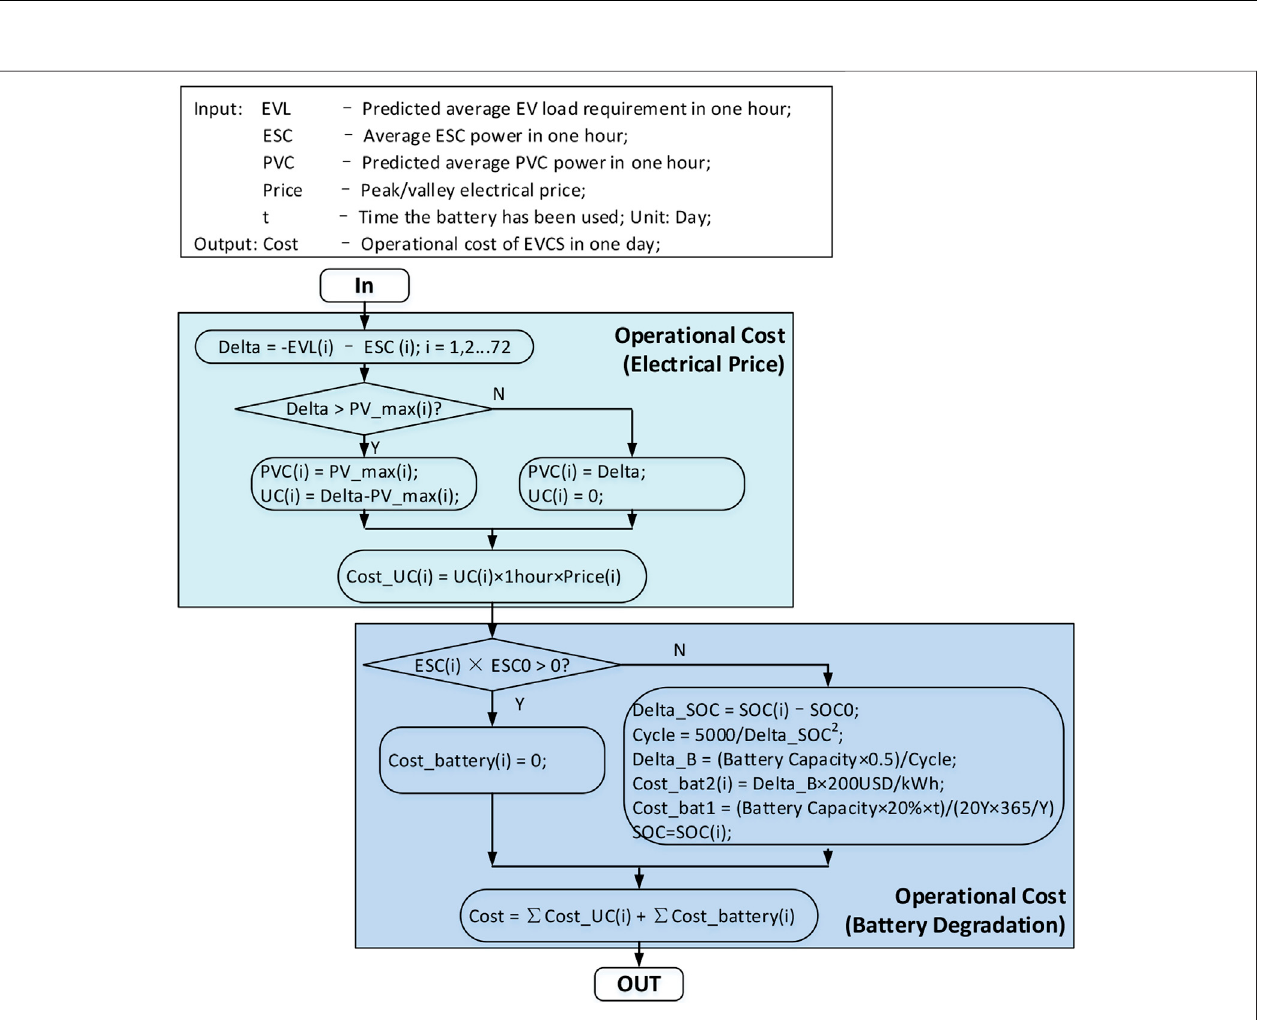
FIGURE 8 | Detailed fl owchart of the fourth functionality (FUN4).